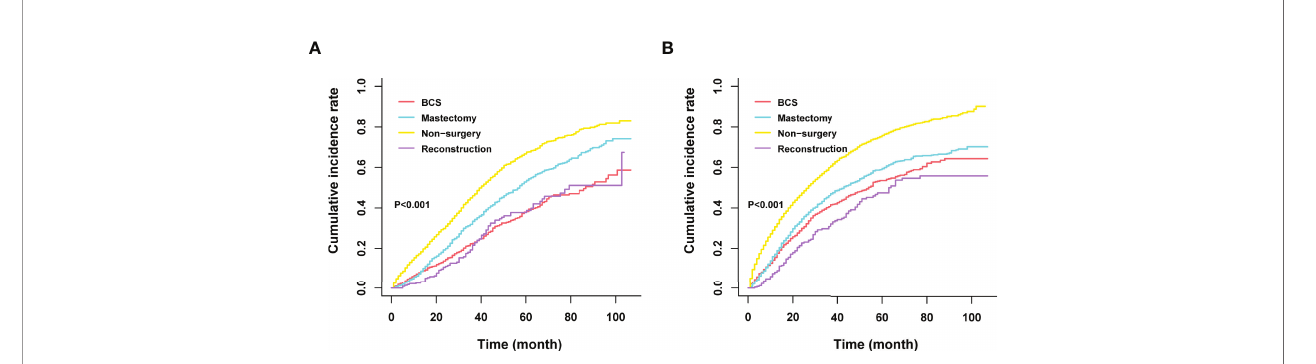
FIGURE 3 | (A) Cumulative incidence rate of BCSD in the bone-only metastatic pattern. (B) Cumulative incidence rate of BCSD in the viscera metastatic